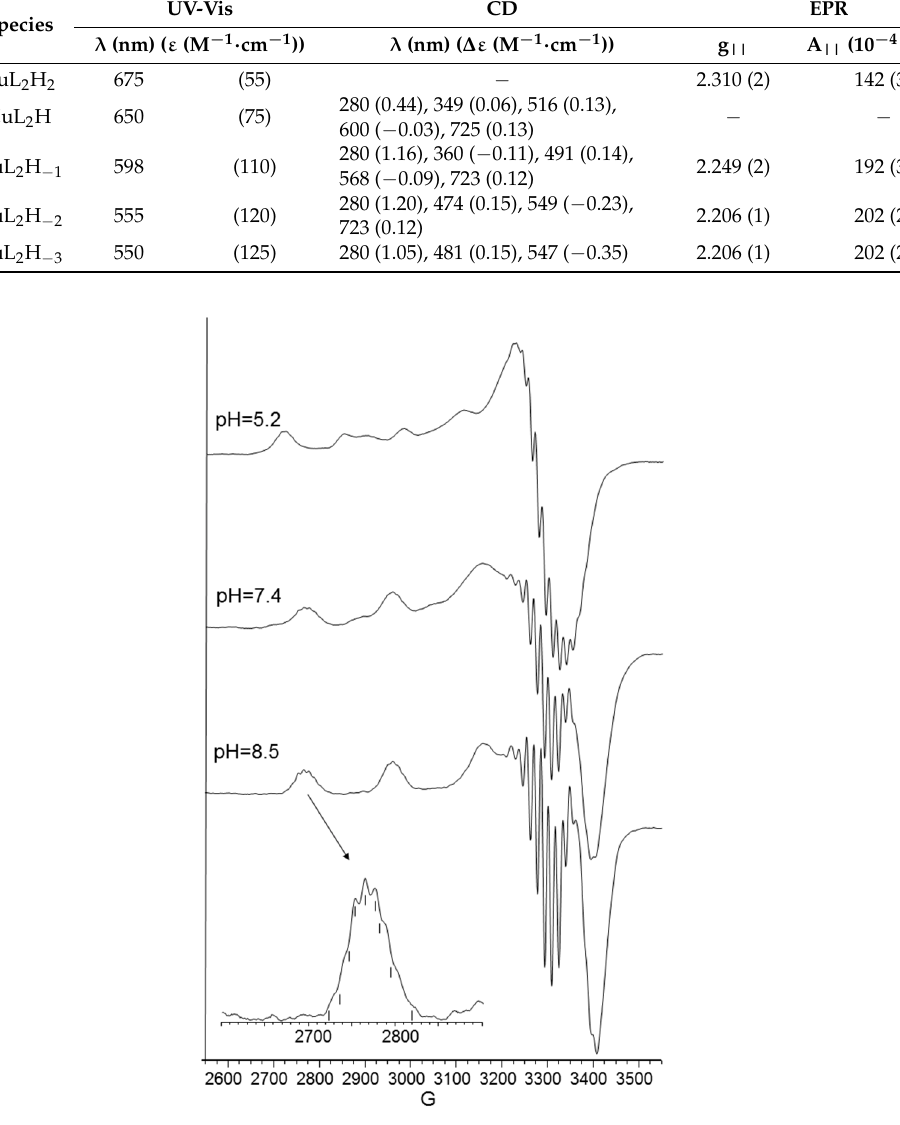
Figure 5. Aqueous frozen solution EPR spectra at 150 K at different pH values of the Cu 2+ -Ac-SLHHLG-NH 2 system at 1:2 metal-to-ligand molar ratio ([Cu 2+ ] = 1 × 10 − 3 mol dm − 3 ; [L] = 2 × 10 − 3 mol · dm − 3 ). The magnification of the first band of EPR spectrum at pH 8.3 (black arrow) shows superhyperfine pattern superimposed on the first copper feature.